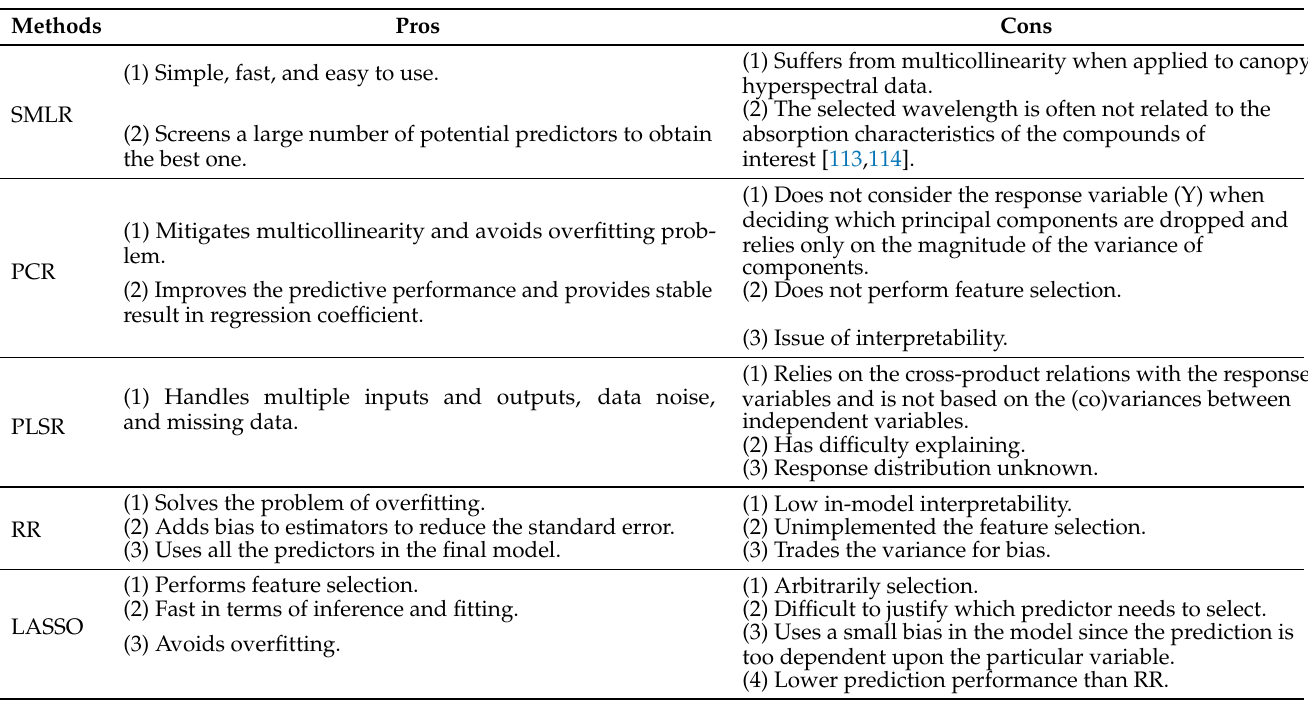
Table 3. Pros and cons of the linear nonparametric